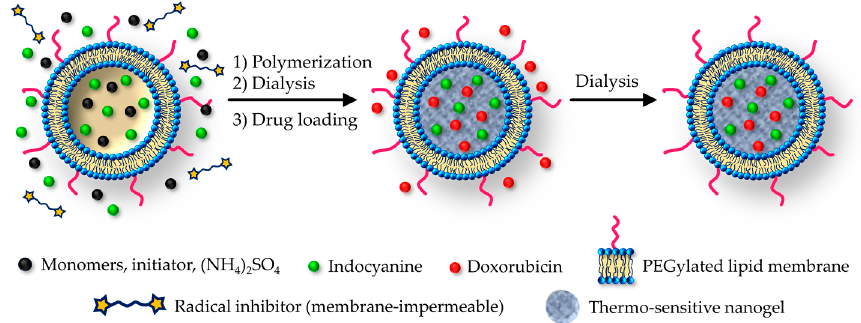
Figure 11. The nanolipogel preparation strategy with the inhibition of polymerization outside the vesicle. Note: the radical inhibitor is a TEMPO-PEG-TEMPO molecule. Adapted with permission from Reference [82]. Copyright (2018) American Chemical Society.